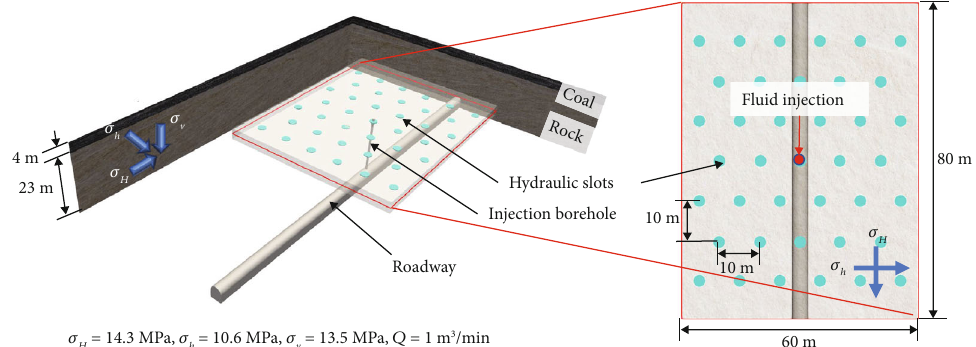
Figure 14: Geometric model and conditions for simulation of hydraulic fracturing in combination with a staggered distribution of hydraulic slots.